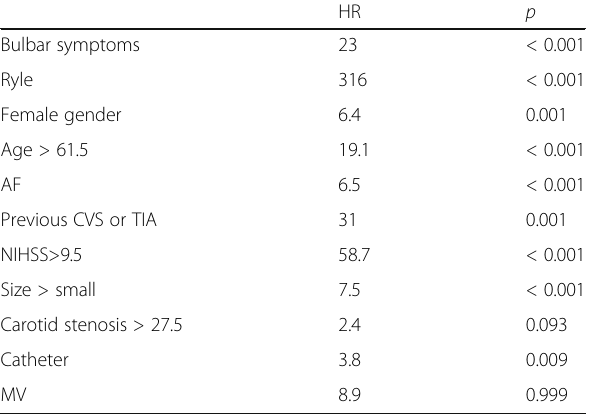
Table 1 Risk factors for post-ischemic stroke pneumonia